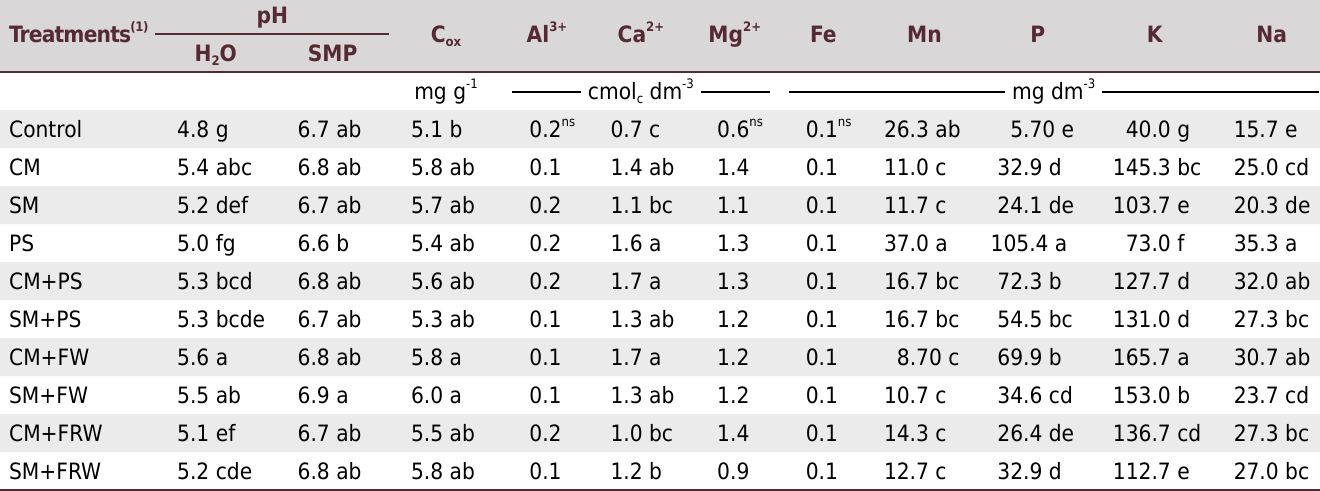
Table 3. Chemical properties of an Acrisol amended with vermicomposts and incubated for 182 days Treatments